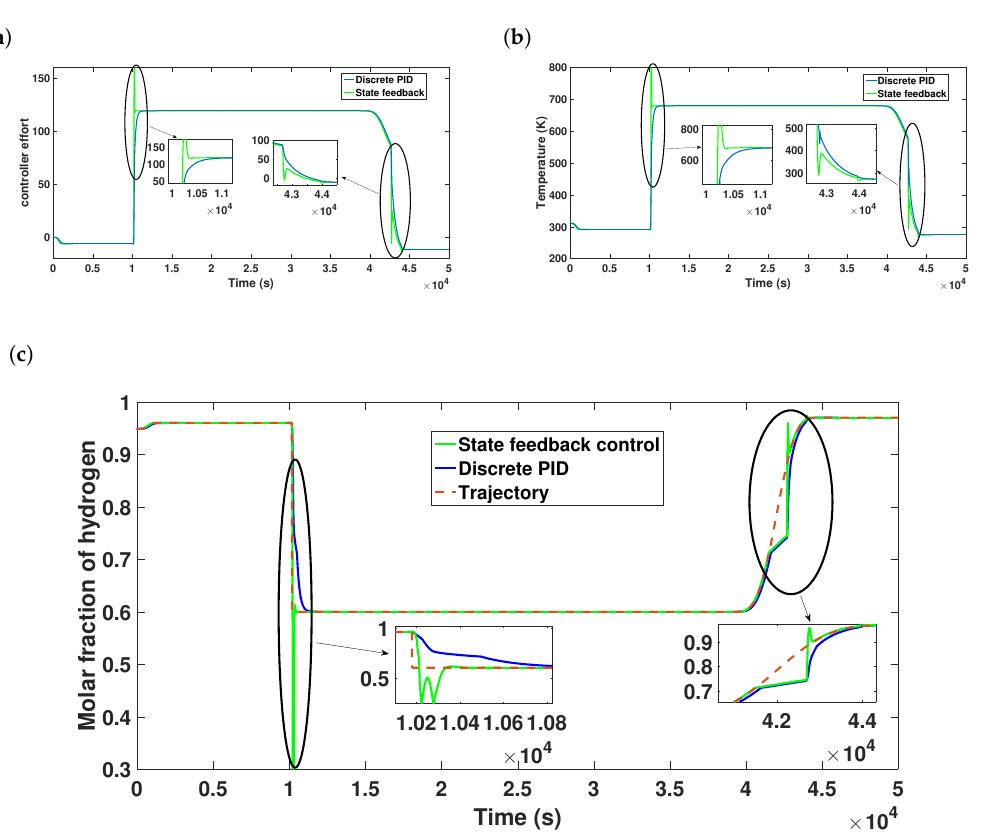
Figure 15. Control signals to reach different purity values and verify the performance of the controller. ( a ) Control signals generated before the block of inverse input functions. ( b ) Control signals generated using the input inverse functions block. ( c ) Hydrogen purity obtained from 4 trajectory changes.